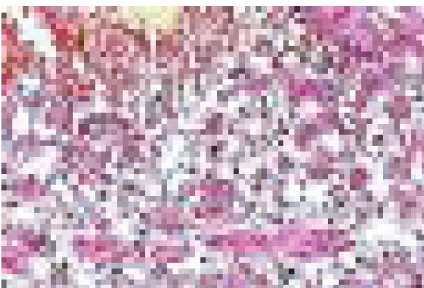
Figure 31: Vasospastic venous angiopathy. Medial muscle showing con fl uent mediolysis distributed in an edematous background containing membranous and organelle remnants, a few intact muscle cells some with cytoplasmic vacuoles, and scattered apoptotic bodies. Hematoxylin & eosin × 200 (adapted with permission from the International Journal of Surgical Pathology 15(2) copyright 2007, Sage Publication).